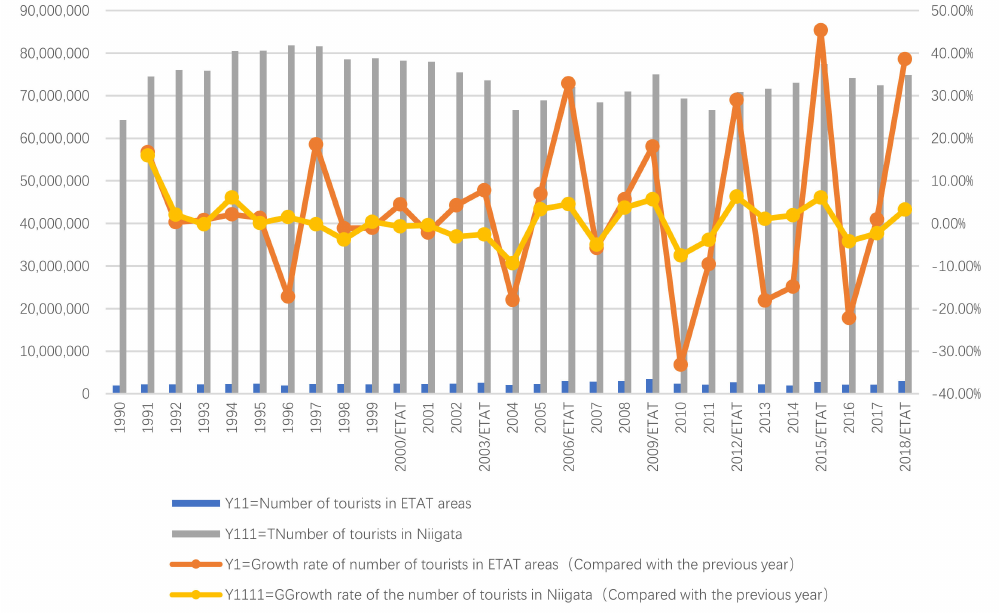
Figure 9. Number of tourists and its growth rate in ETAT areas (1990–2018).